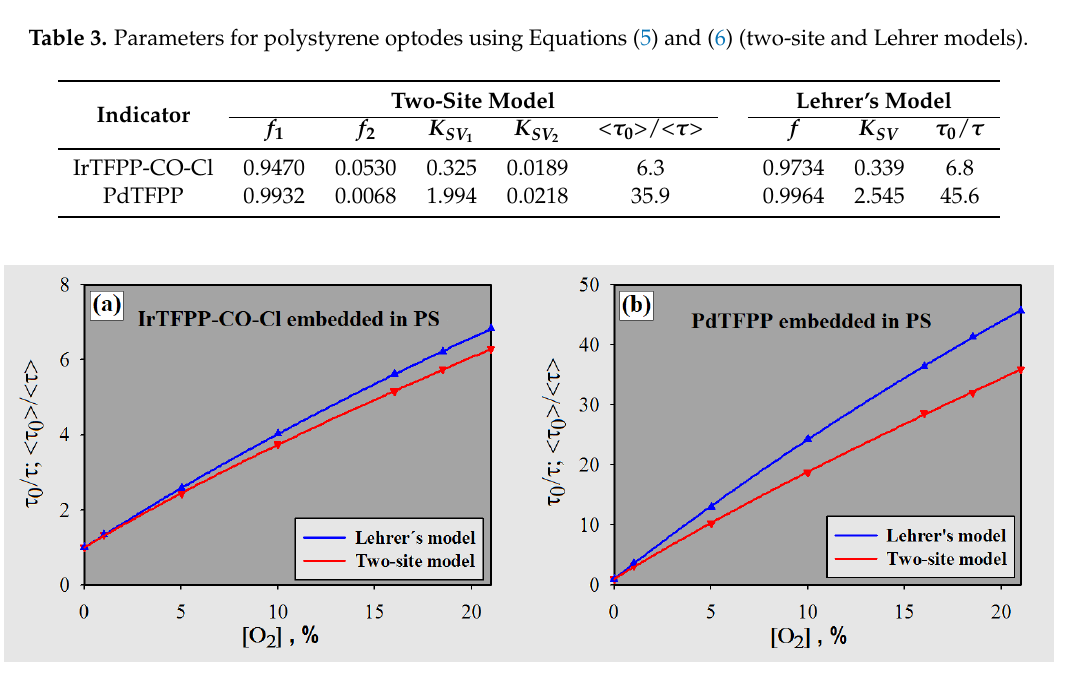
Figure 8. Modified Stern–Volmer plots for ( a ) IrTFPP-CO-Cl and ( b ) PdTFPP embedded in polystyrene (r 2 > 0.9999 for all